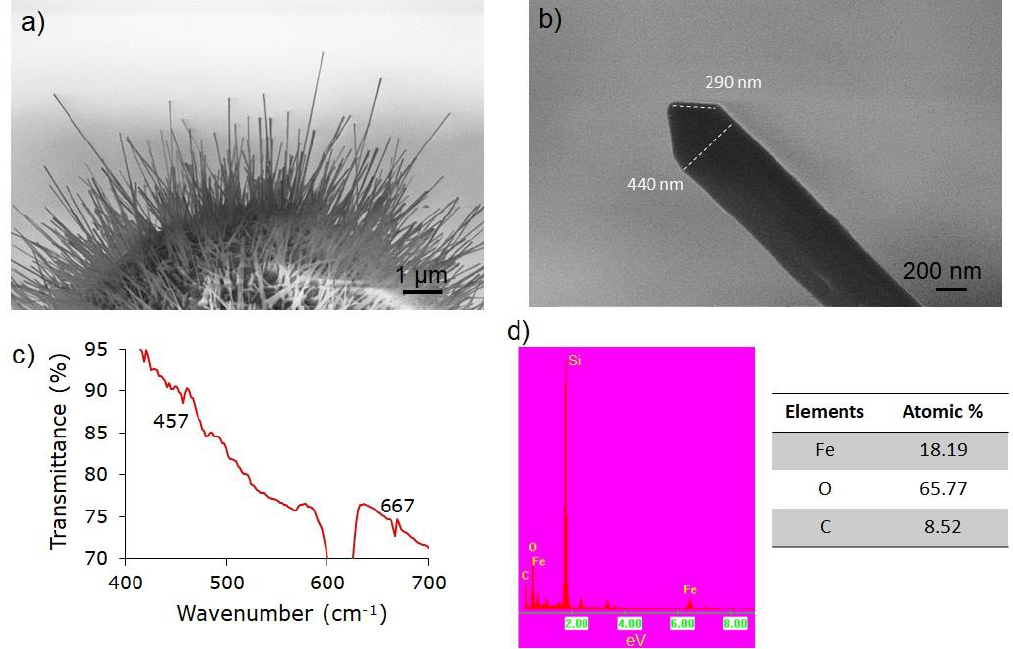
Figure 4. ( a ) SEM cross-sectional image of iron oxide nanostructures after carbothermal heat treatment showing the formation of iron oxide growing radially outward from the surface of Fe microspheres. ( b ) Representative high-resolution image of an iron oxide nanowire with well-defined edges. ( c ) FTIR spectra, ( d ) EDS spectra, and semi-quantitative analysis of the iron oxide nanostructures confirming the formation of the Fe 2 O 3 phase.